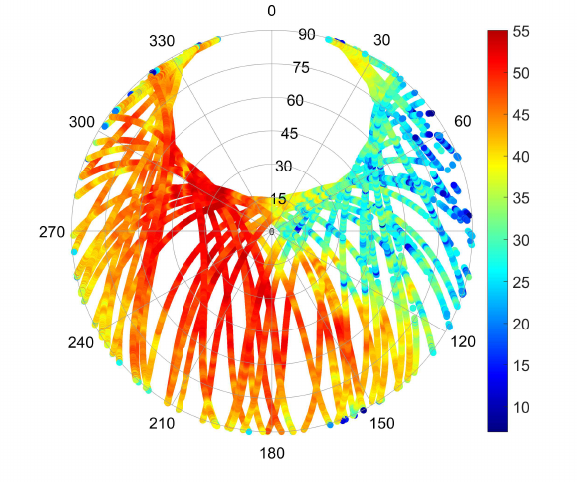
Figure 3. Sky plot of the SNR of the data collected by the West antenna on epoch 137